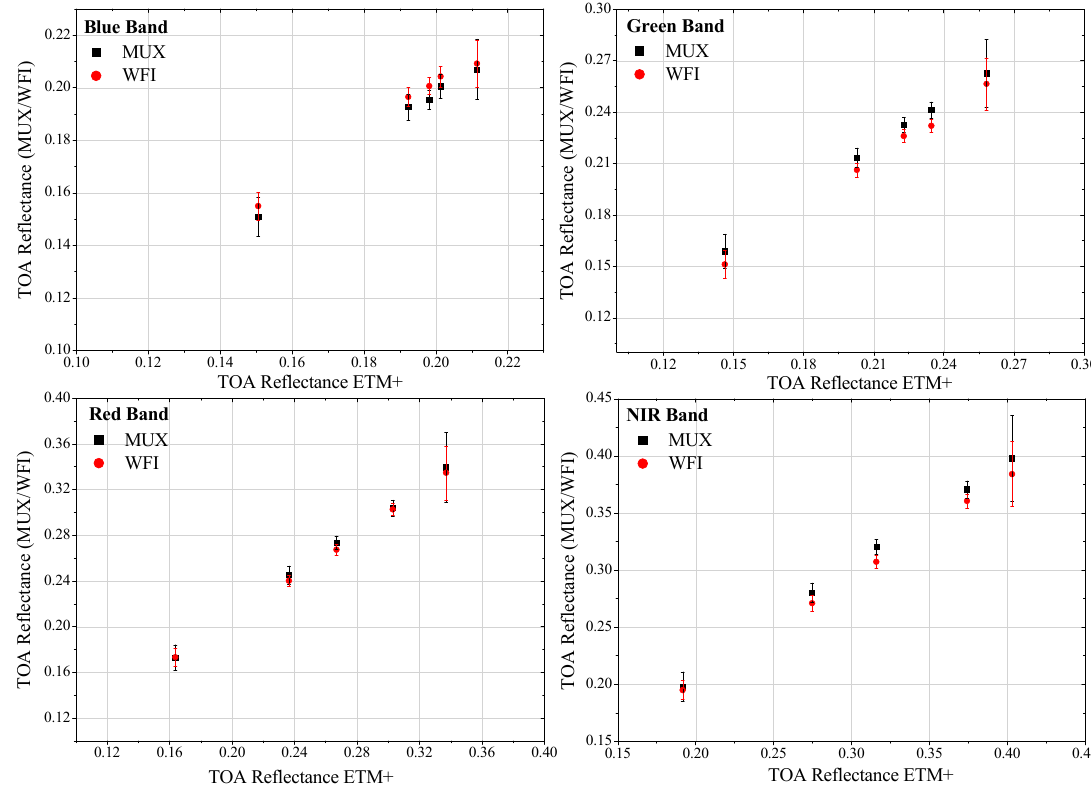
Figure 11. TOA reflectance comparison between Landsat-7 ETM+ and CBERS-4 (MUX and WFI) after application of the SBAF.